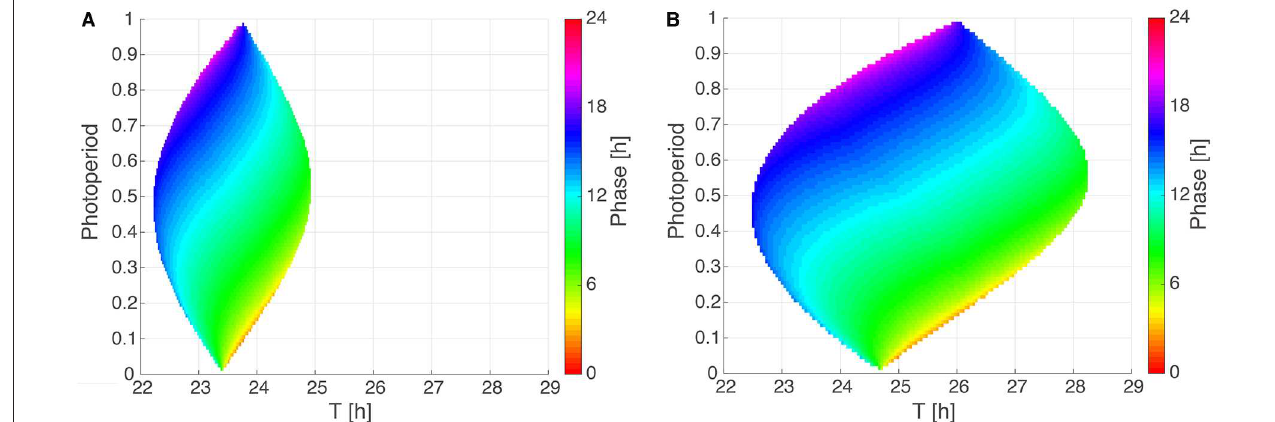
Frontiers in Physiology |